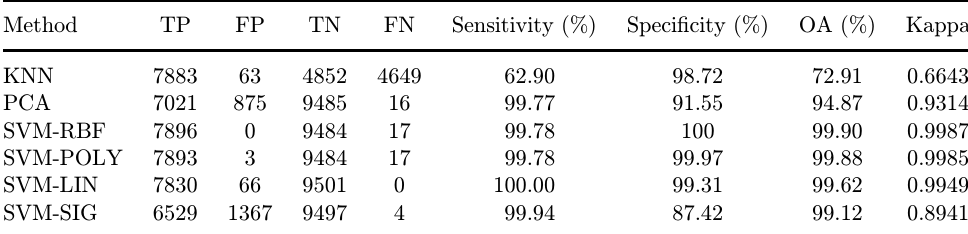
Table 2. Classi¯cation performance of di®erent